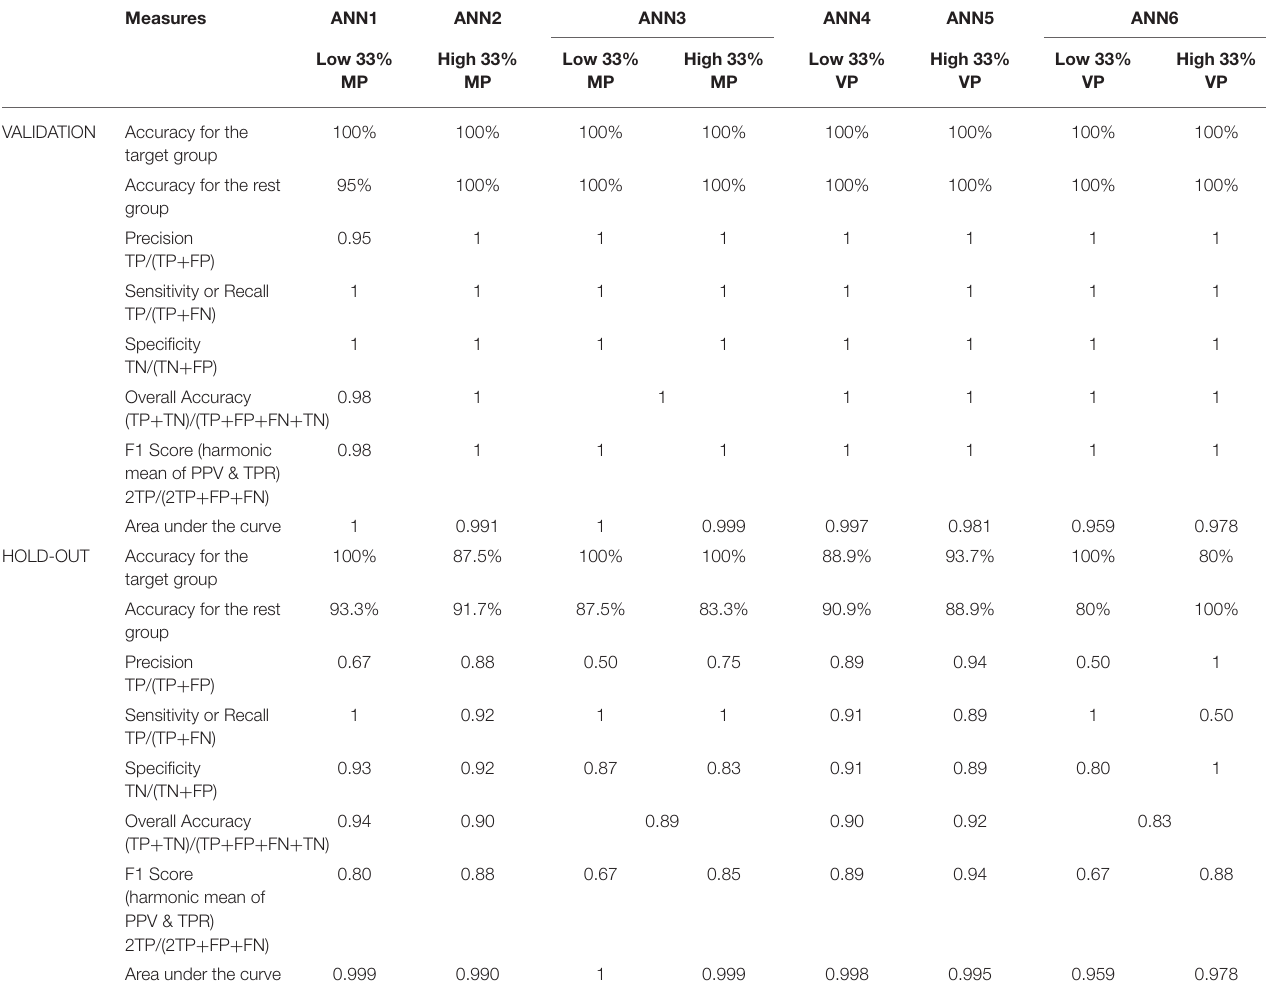
TABLE 4 | Measures for ANN